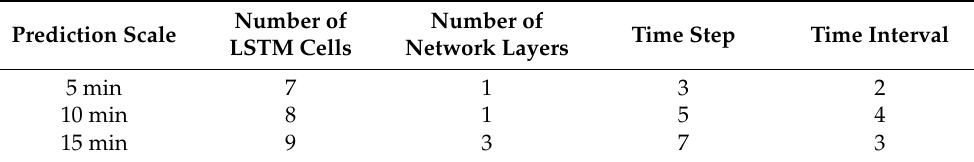
Table 3. Optimization results of DNI prediction model parameters at different scales. Prediction Scale